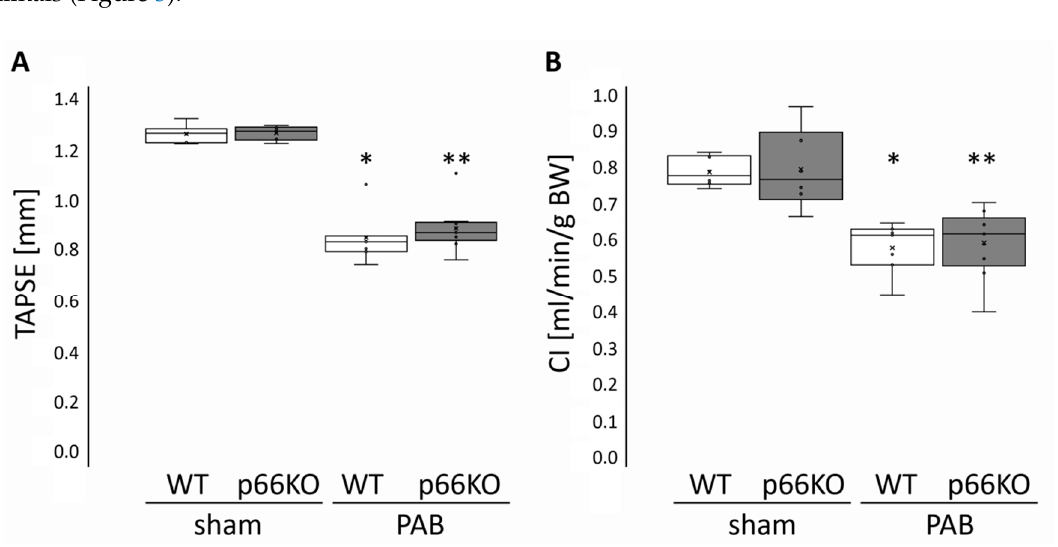
Figure 3. Cardiac function in mice three weeks after pulmonary artery banding (PAB) or sham surgery. ( A ) Tricuspid annular plane systolic excursion (TAPSE, in mm) and ( B ) cardiac index (CI, in ml / min / g BW). Data are given for wild type (WT) and p66shc knockout (p66KO) mice three weeks after sham surgery ( n = 6 each group) and for WT and p66KO mice three weeks after PAB ( n = 7 and n = 9, respectively). Data are expressed as 25%, 50%, and 75% quartiles with whiskers representing the total range. The dots represent the individual data points. *: p < 0.05 vs. WT sham and **: p < 0.05 vs. p66KO sham as analyzed by two-way ANOVA.